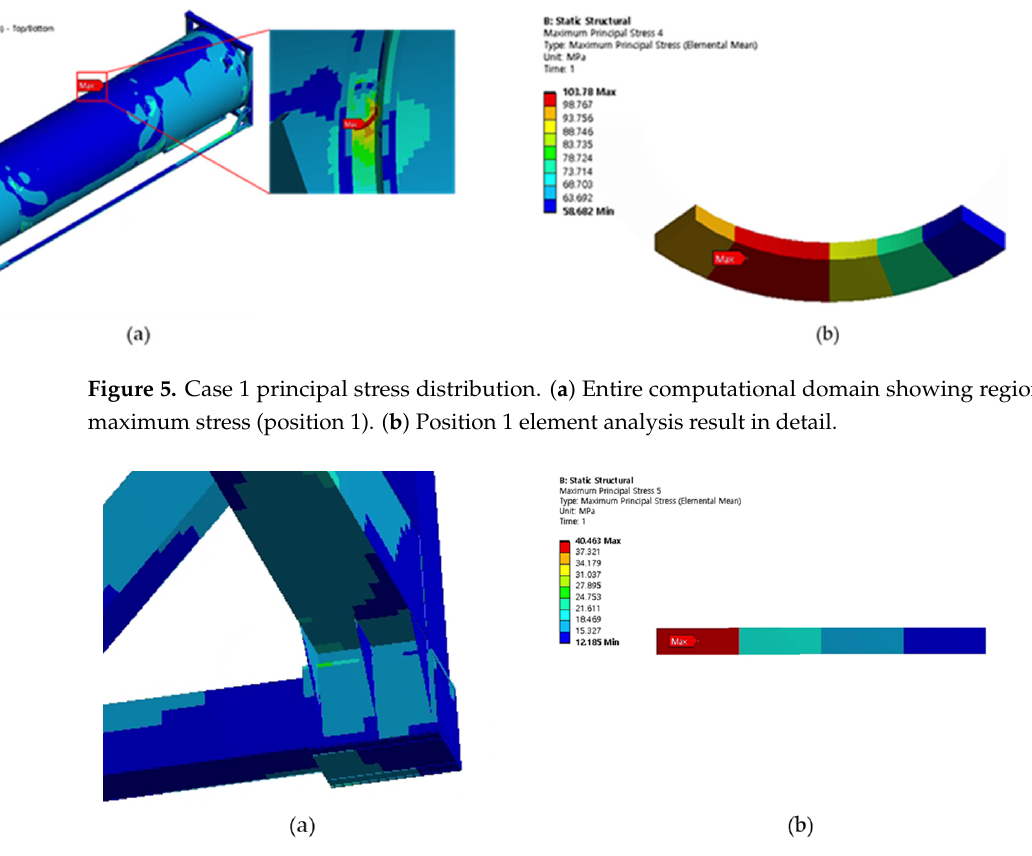
Figure 6. Case 1 principal stress distribution. ( a ) Entire computational domain showing region of maximum stress (position 2). ( b ) Position 2 element analysis result in detail.